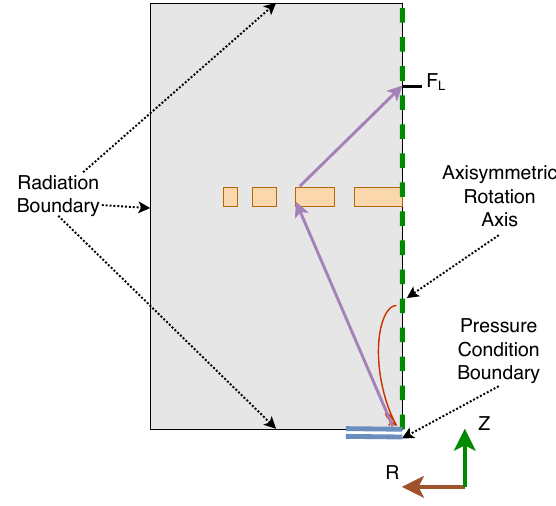
Figure 2. Scheme of the finite element method (FEM)